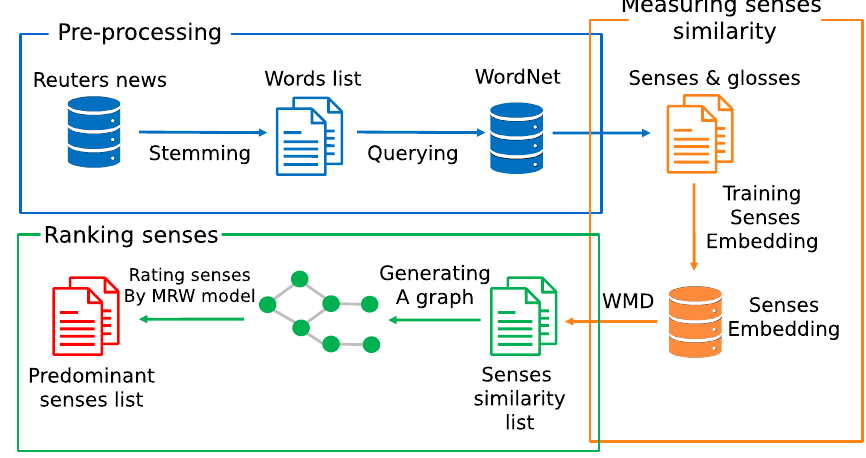
Figure 1. Framework of Domain-Specific Senses